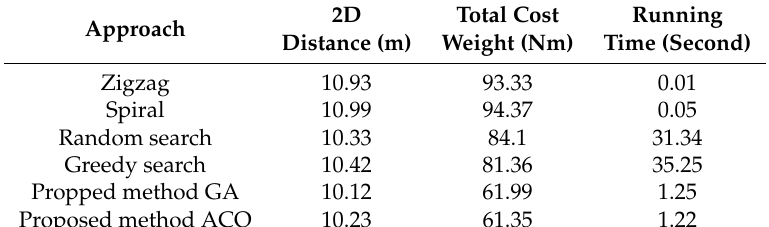
Table 3. Costweight and generation time of CACP approaches.